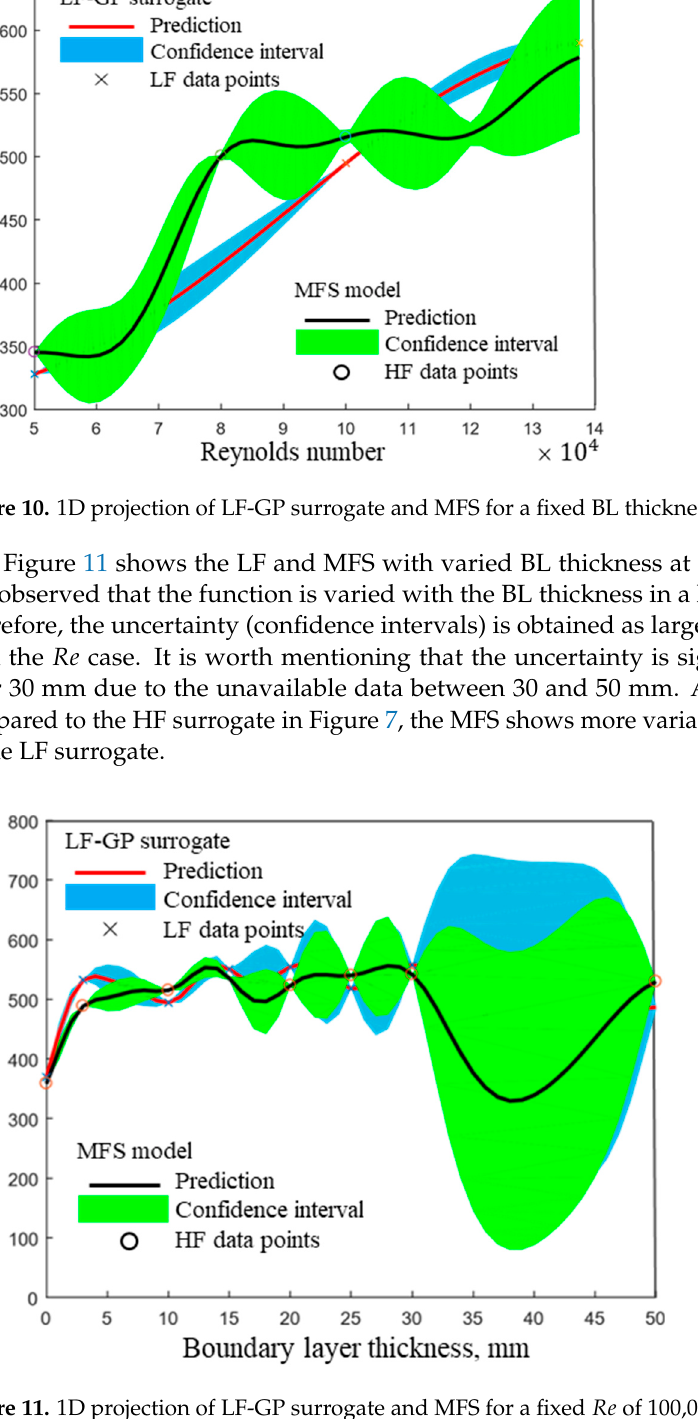
Figure 11. 1D projection of LF-GP surrogate and MFS for a fixed (cid:2174)(cid:2187) of 100,000. The RMSE and error rate based on the number of HF data are shown in Figure 12.